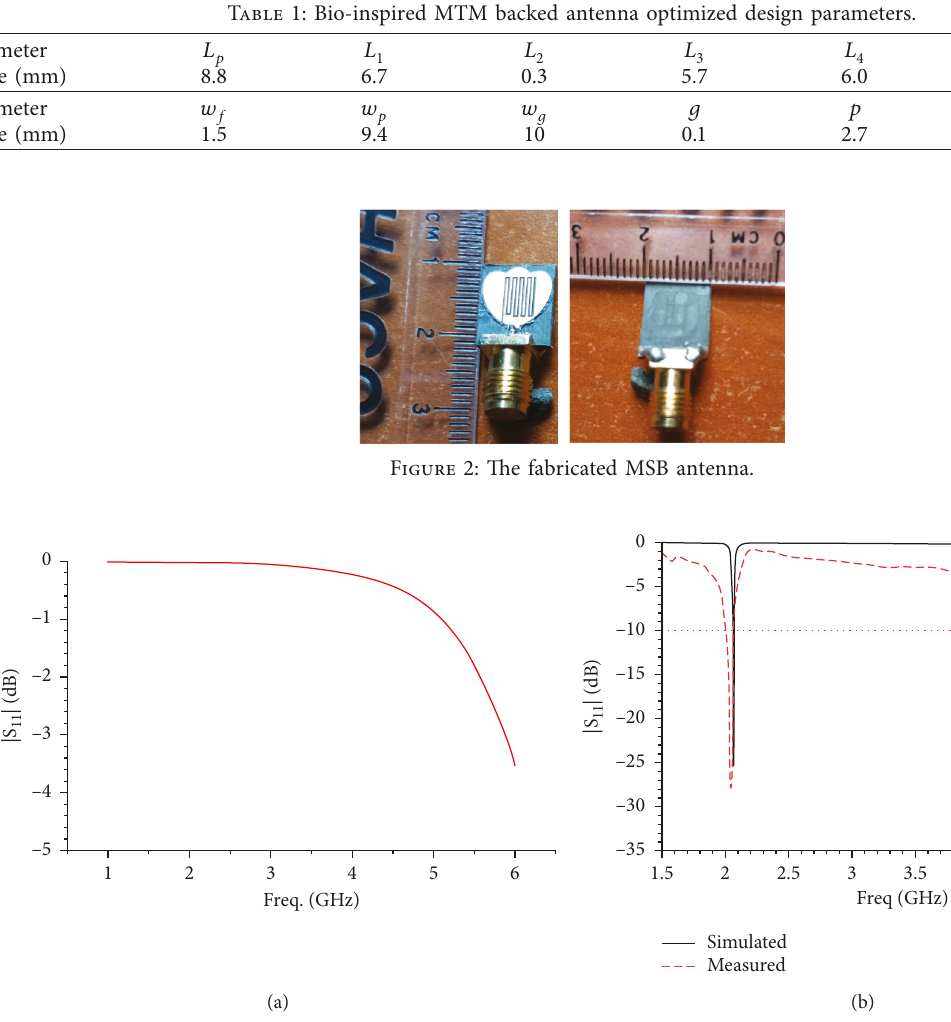
Figure 3: (a) The |S 11 | response of the initiator, (b) reflective response of the proposed MSB antenna.